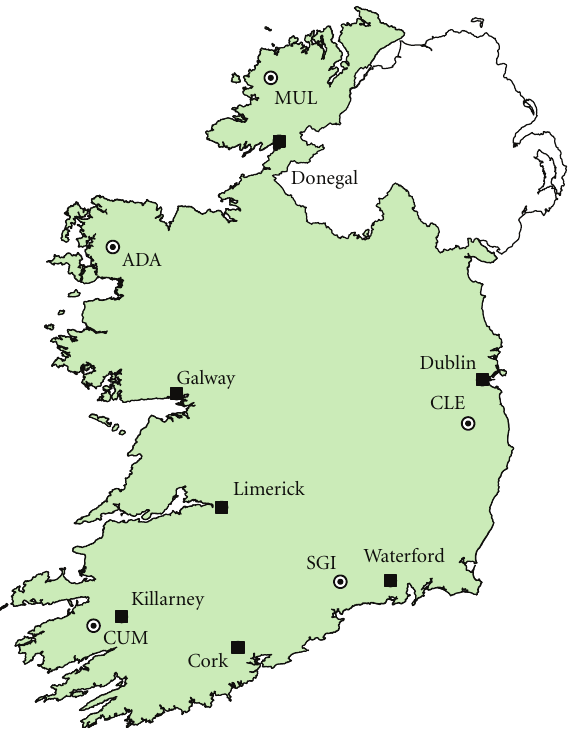
Figure 1: Location of the five study sites (circles) and major cities (filled squares) in the Republic of Ireland (green shading): Lough Cummeenoughter (CUM), Lough Adanacleveen (ADA), Mullincrick Lough (MUL), Sgilloge Lough (SGI), and Cleevaun Lough